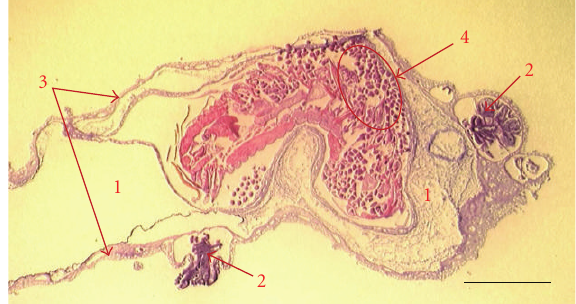
Figure 10: An unidentified commensal organism (possibly poly- chaete) with potential gonads associated into the axis of Paraco- rallium japonicum ; OCA-Cn20090420-036. 1: axis, 2: autozooid, 3: gonads. Scale bar is 1.0 mm.